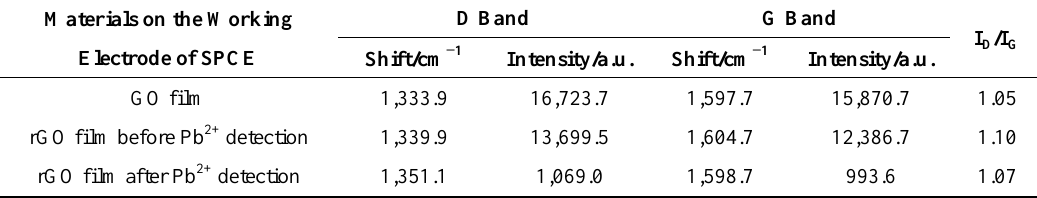
Table 1. A summary of Raman shift and intensity obtained from various